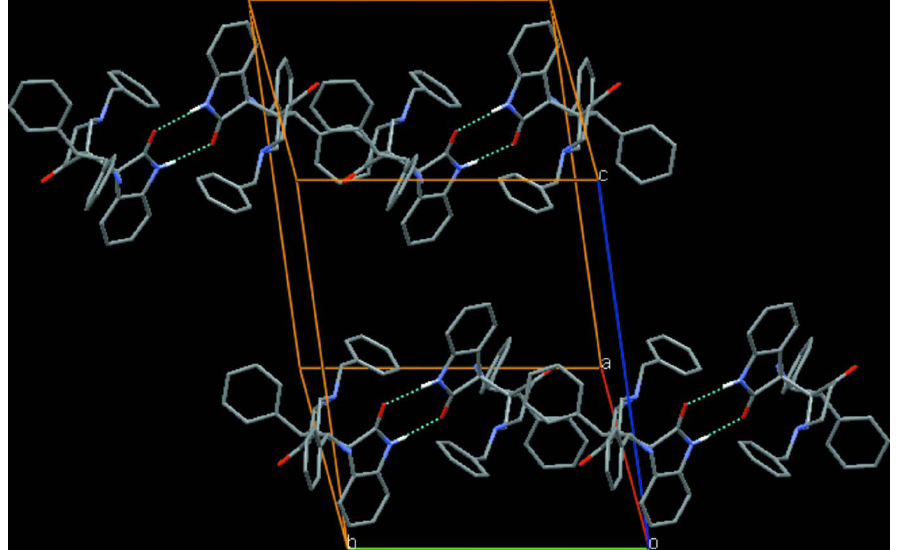
Figure 3 A partial packing view showing the intermolecular N—H···O interactions (dashed lines) generating an R 22 (8) graph-set motif in the title compound. H atoms are omitted for